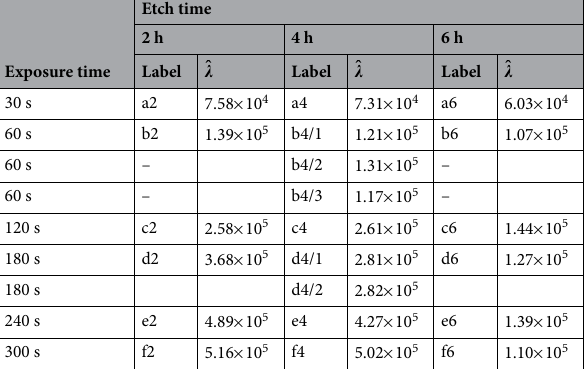
Table 1. List of investigated samples and exposure and etching conditions. Letters will be used for the figure’s 2 label. ˆ (cid:31) is the registered track density in cm − . All samples were etched in 6.25 N NaOH at 70 ◦ C. Raw data that was used in the analysis is provided in the supplementary information files.